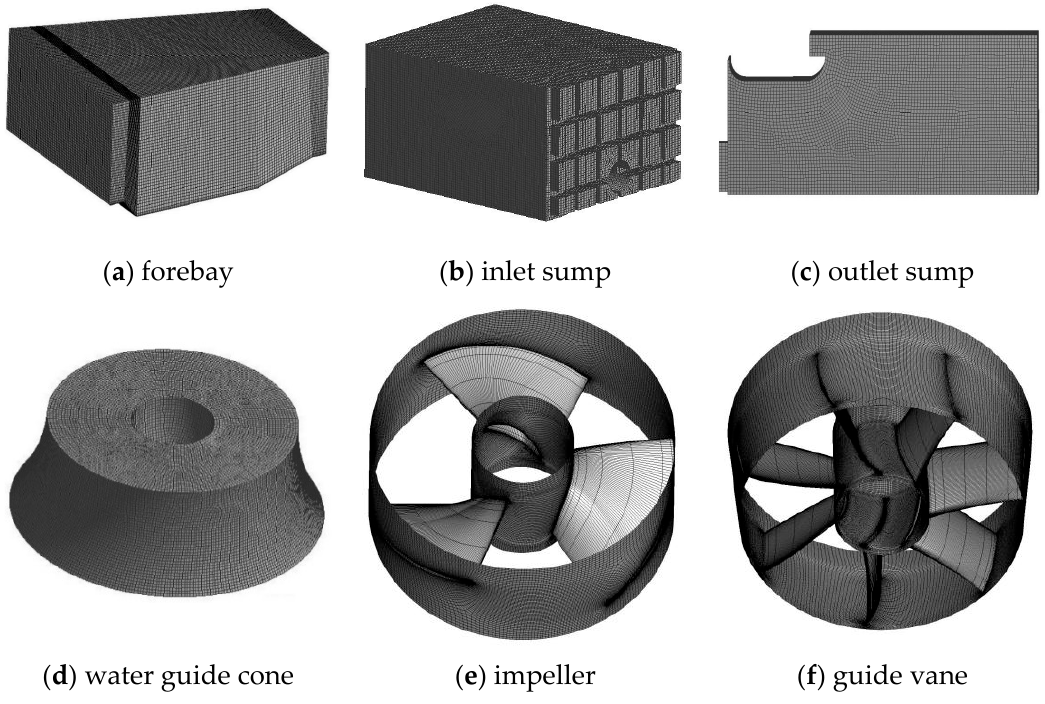
Figure 4. Computational grid diagram.